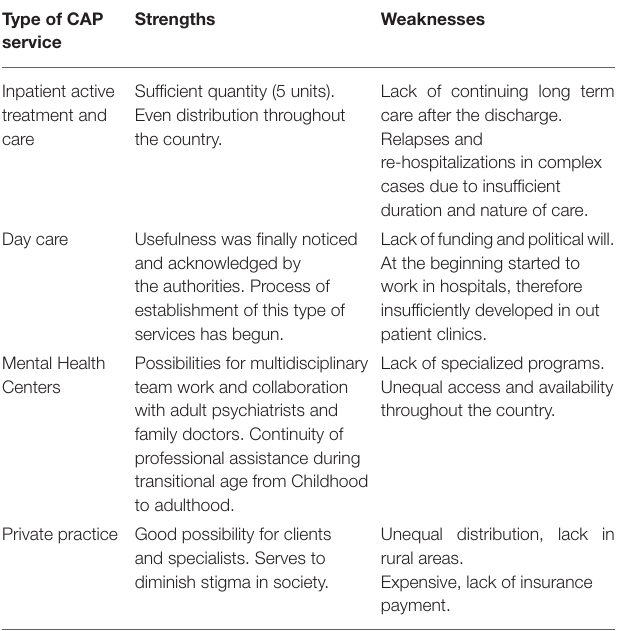
TABLE 1 | The main strength and weaknesses in CAP service